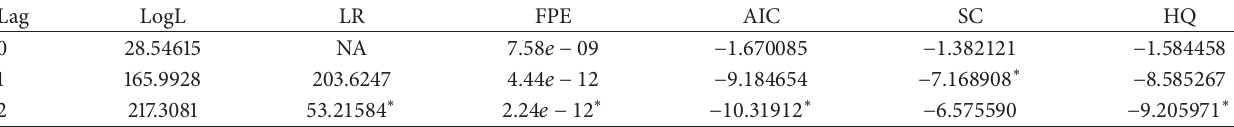
Table 3: Lag length test results.